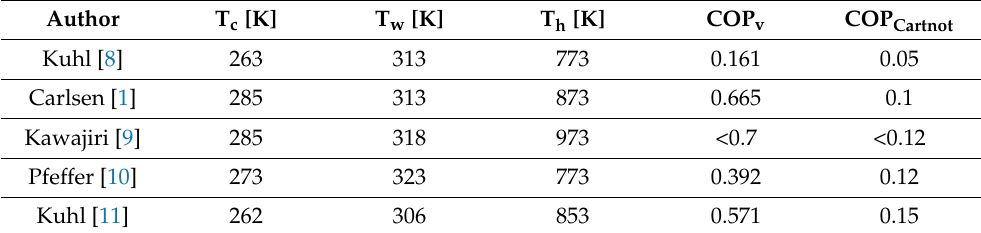
Figure 1. Schematic of free piston Vuilleumier machine. Table 1. A summary of performance of Vuilleumier heat pumps.